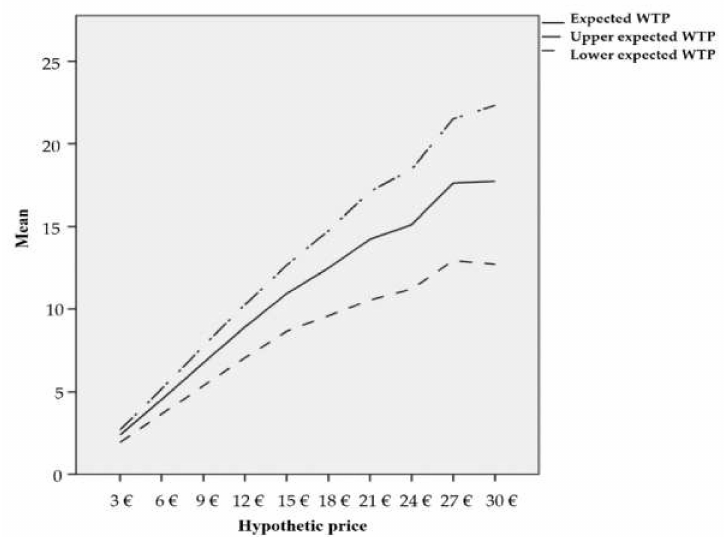
Figure 3. Maximum, medium, and minimum expected willingness to pay. Source: own processing based on obtained